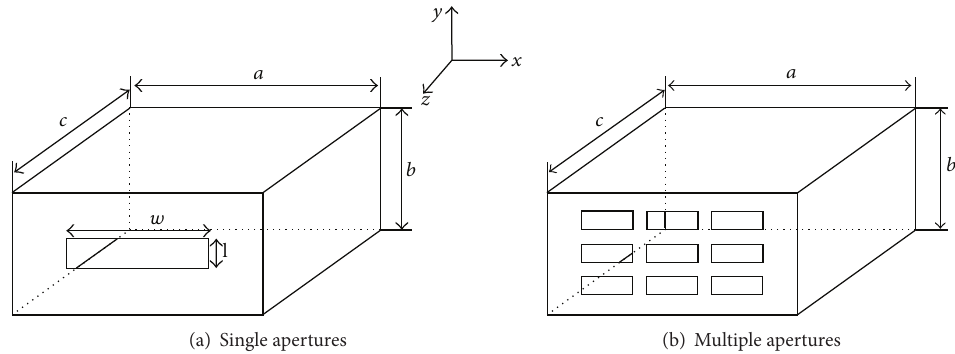
F 1: Geometry of a rectangular metallic enclosure with rectangular